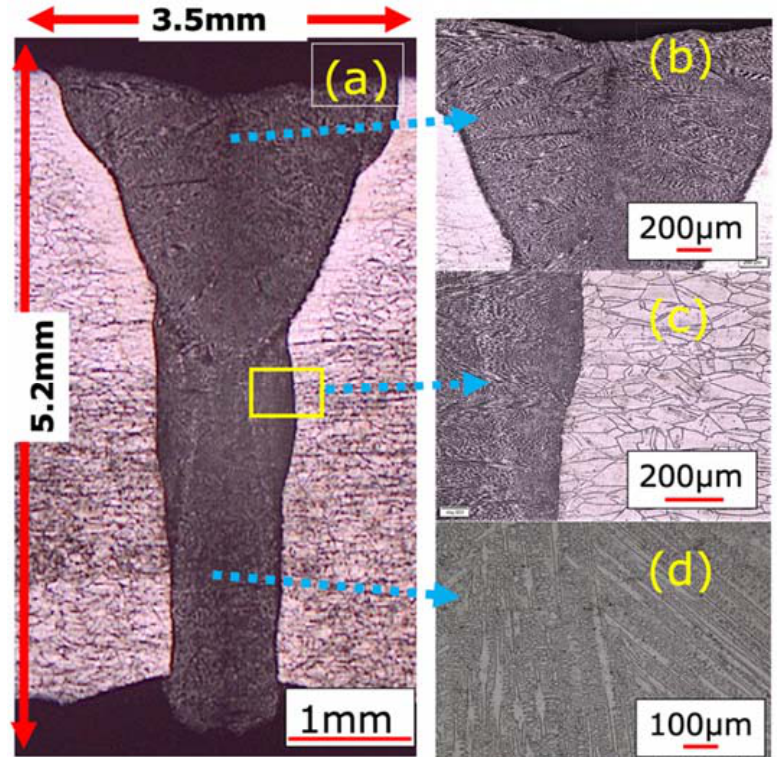
Figure 8. ( a ) Macrograph of Inconel 625 laser beam welded joint (weld 3) showing a defect-free weld with full penetration and optical microscope images of the ( b ) weld cap, ( c ) HAZ, and ( d ) weld root. No solidification or liquation cracking at the FZ/HAZ interface occurred in the present Inconel 625 butt-welded joints. This is a consequence of the lower heat input of the CO 2 laser beam process compared to arc welding processes where, in contrast, such